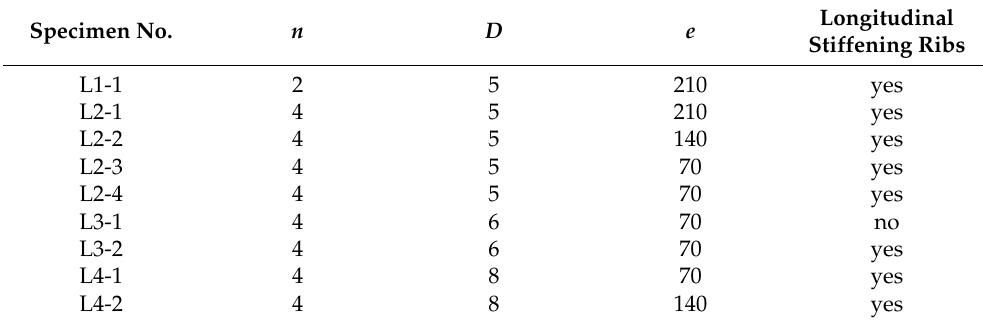
Table 1. Bolt layout parameters of each test specimen (unit: mm). Specimen No.